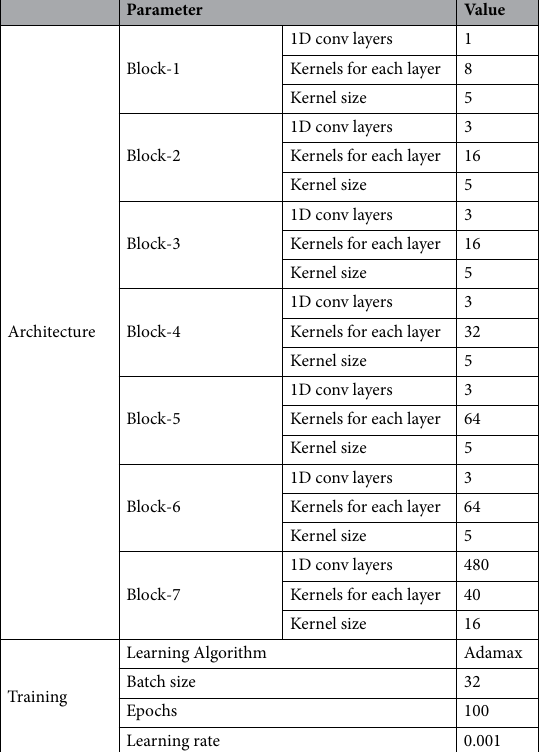
Table 3. Parameter values used in the 1-D CNN.